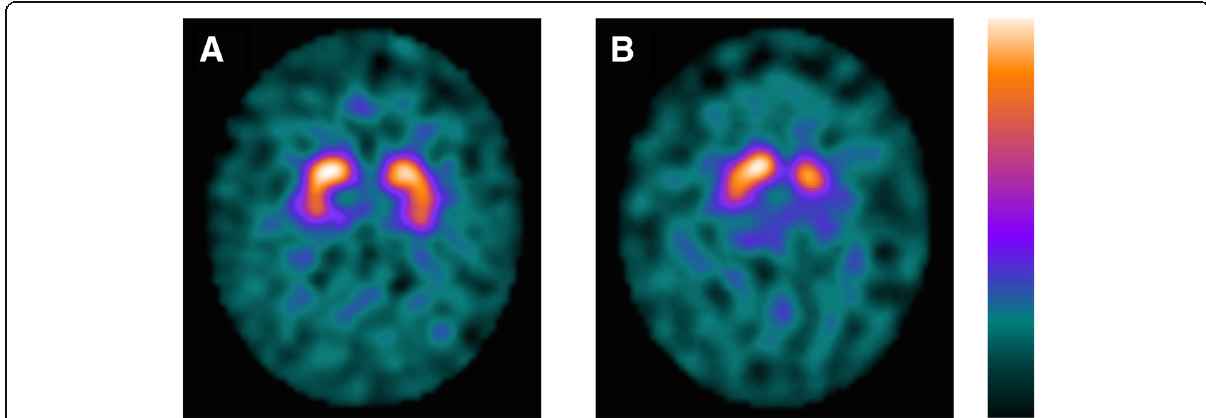
Fig. 1 DAT SPECT imaging. Normal ( a ) and abnormal ( b ) [ 123 I]FP-CIT SPECT imaging of patients in the LEAP cohort. Patient A is a 64-year-old male. Patient B is a 63-year-old female. DAT, dopamine transporter; SPECT; single-photon emission computed tomography; LEAP, Levodopa in EArly Parkinson ’ s disease